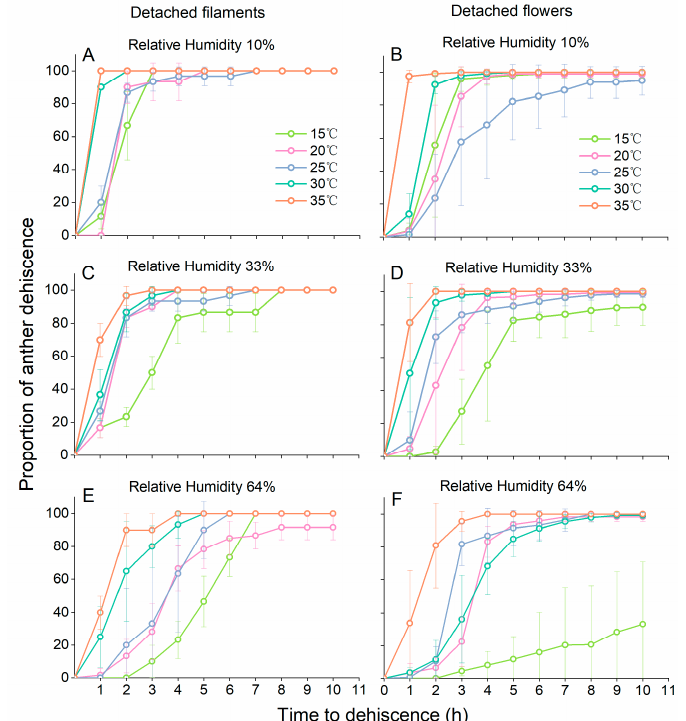
Figure 3. Effect of temperature and relative humidity on time to anther dehiscence in detached filaments and detached flowers. The panels ( A , C , E ) represent anther dehiscence in detached filaments at 10% RH, 33%RH and 64% RH, and the panels ( B , D , F ) represent anther dehiscence in detached flowers at 10% RH, 33%RH and 64% RH. Data are presented as the mean ± S.D. At least three filament groups (each group contained 10 undamaged filaments) and at least six undamaged flowers were observed in each experimental unit.